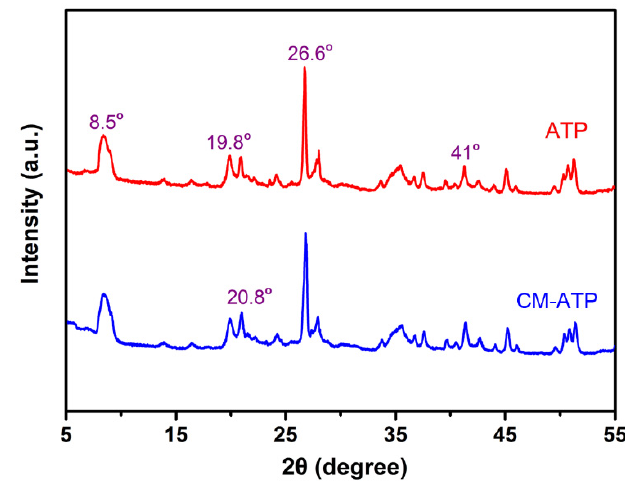
Figure 2. X-ray diffraction (XRD) patterns of samples.